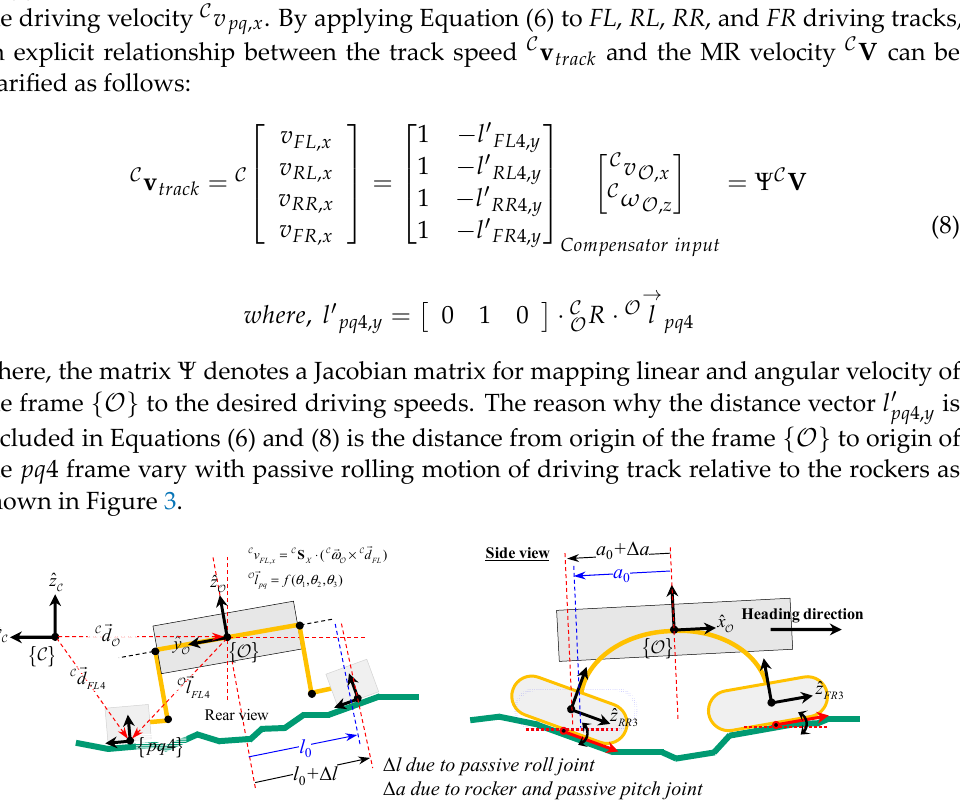
Figure 3. Variation of the transverse distances between the main body and driving track due to passive rolling motion of the driving track.